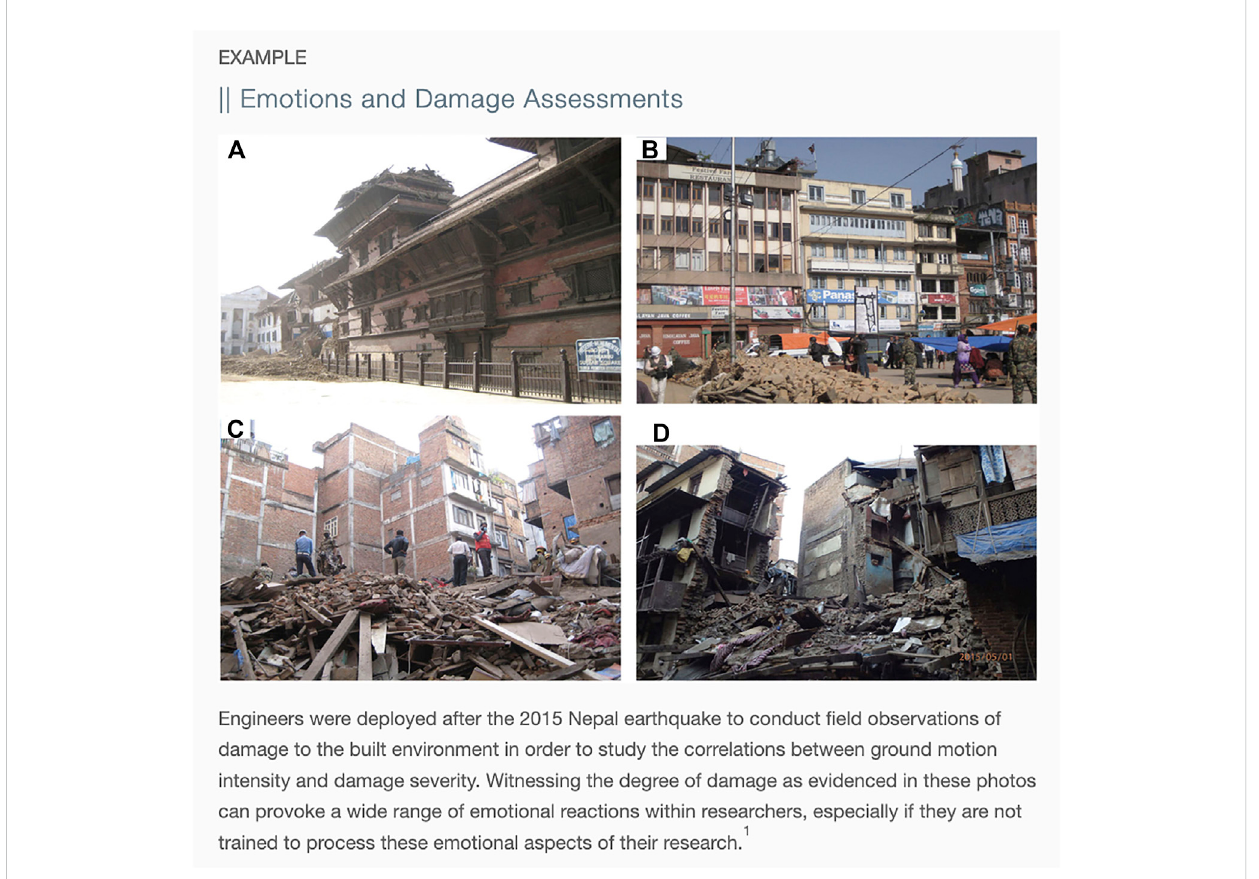
FIGURE 2 Example case study from the CONVERGE Conducting Emotionally Challenging Research Training Module. (A) Collapse of the Basantapur Tower in theKathmanduDurbarSquare. (B) UndamagedbuildingsoppositeoftheBasantapurTowerintheKathmanduDurbarSquare. (C)